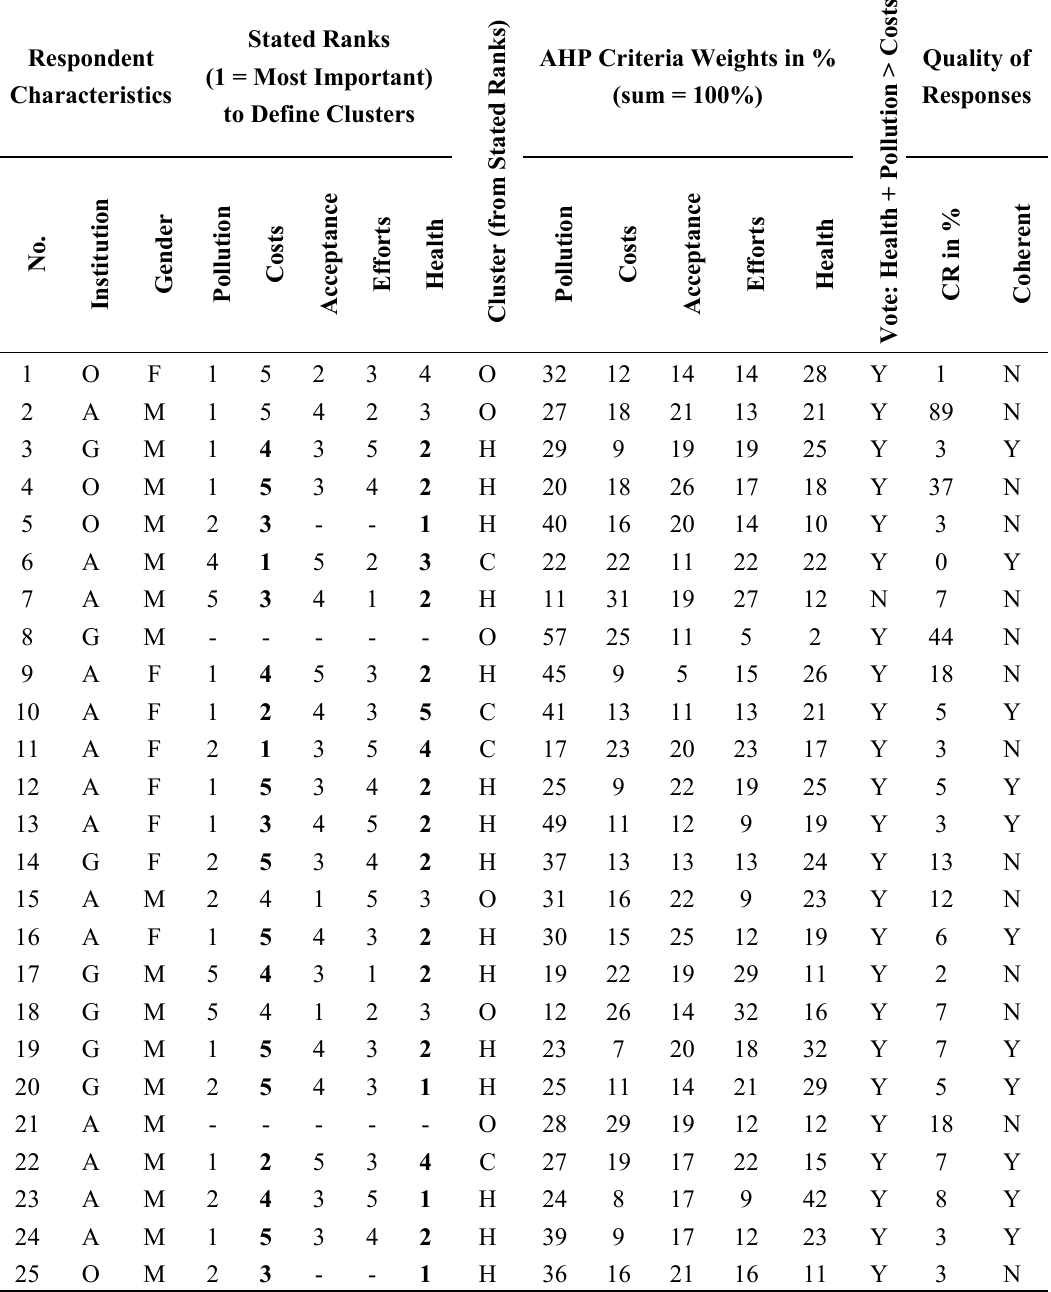
Table 4. Stakeholder representatives’ characteristics, clustering, and criteria